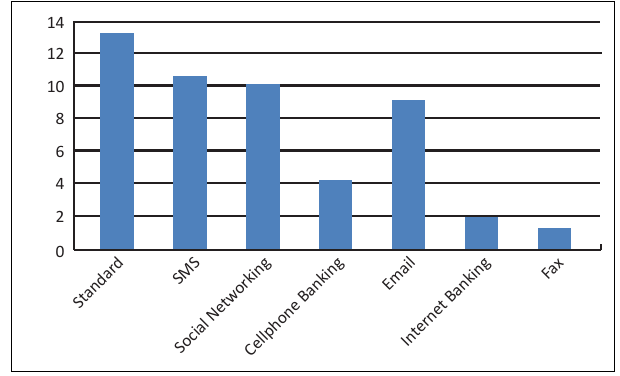
FIGURE 7: Smartphone usage.